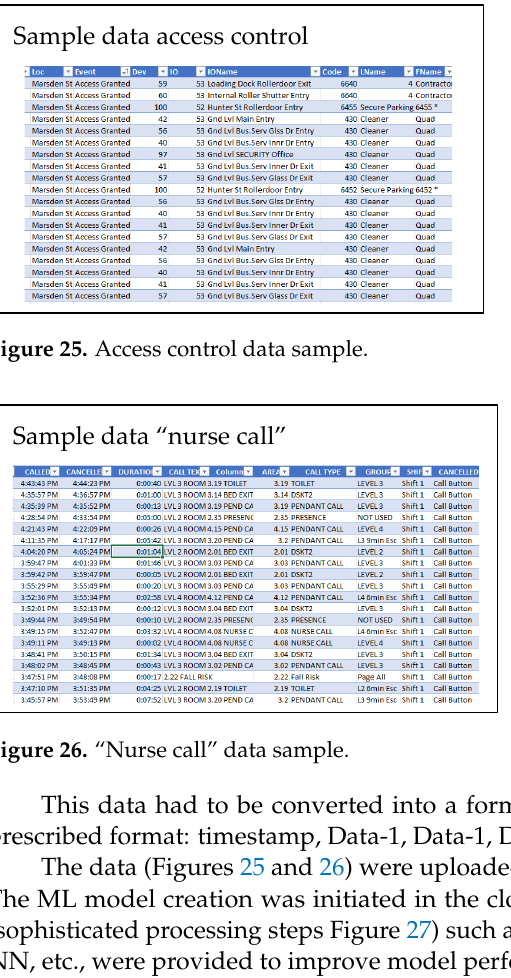
Figure 24. Data upload options provided by the service provider. The data samples are shown in Figures 25 and 26.